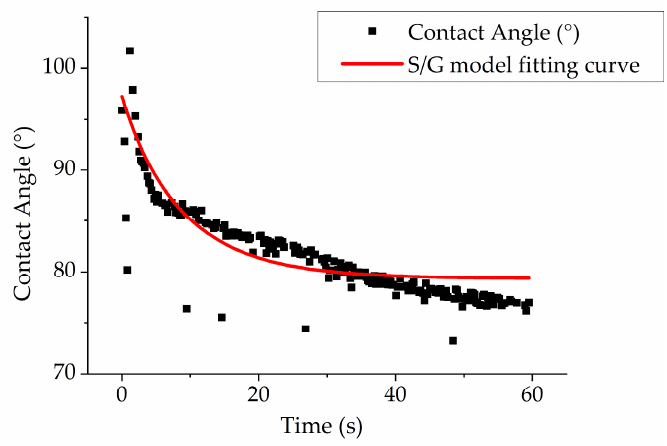
Figure 8. S/G model fitting curve of glycerol contact angle (Sample 4).